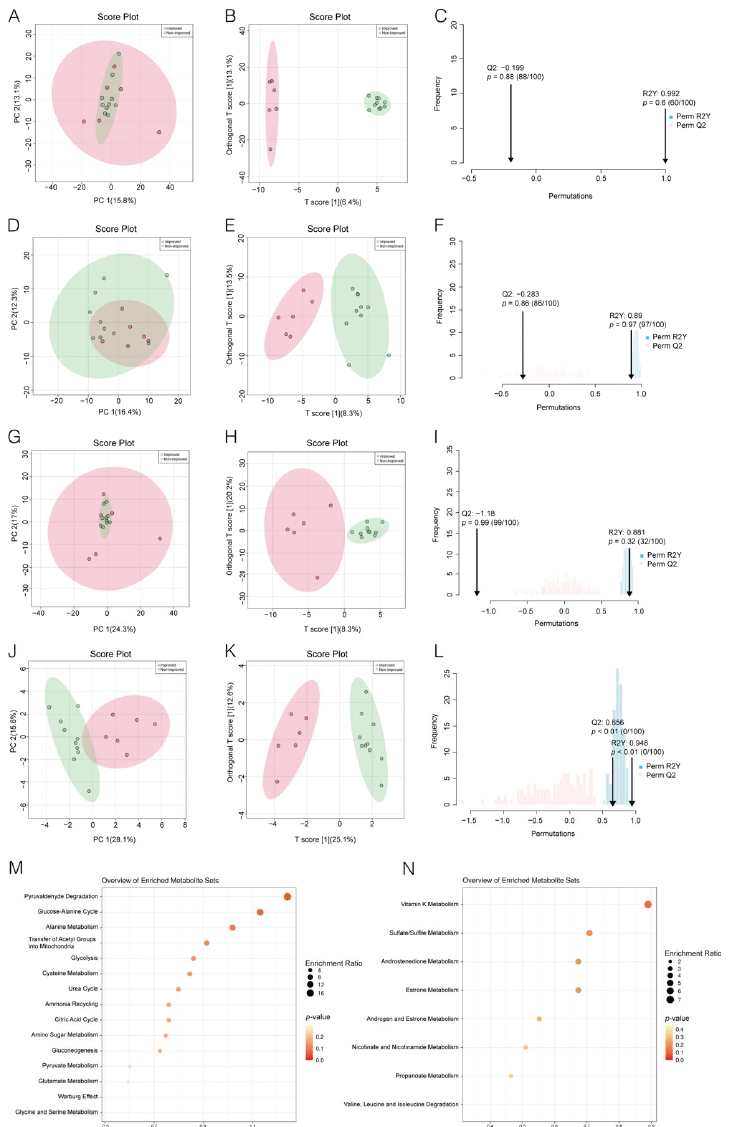
Figure 3. Separation and classification of metabolic profiles in preoperative plasma from non-improved cardiac function (nICF) patients and improved cardiac function (ICF) patients: ( A ). Principle Component Analysis (PCA) score plots based on 714 endogenous metabolites. ( B ). Orthogonal Partial least squares Discriminant Analysis (OPLS-DA) score plots based on 714 endogenous metabolites. ( C ). Permutation test of OPLS-DA score plots based on 714 endogenous metabolites. ( D ). PCA score plots based on metabolites that were upregulated in nICF patients. ( E ). OPLS-DA score plots based on metabolites that were upregulated in nICF patients. ( F ). Permutation test of OPLS-DA score plots based on metabolites that were upregulated in nICF patients. ( G ). PCA score plots based on metabolites that were downregulated in nICF patients. ( H ). OPLS-DA score plots based on metabolites that were downregulated in nICF patients. ( I ). Permutation test of OPLS-DA score plots based on metabolites that were downregulated in nICF patients. ( J ). PCA score plots based on metabolites that were significantly different between nICF patients and ICF patients. (K). OPLS-DA score plots based on metabolites were significantly different between nICF patients and ICF patients. ( L ). Permutation test of OPLS-DA score plots based on metabolites that were significantly different between nICF patients and ICF patients. ( M ). Enrichment analysis based on metabolites that were significantly upregulated in ICF patients. ( N ). Enrichment analysis based on metabolites that were significantly upregulated in nICF